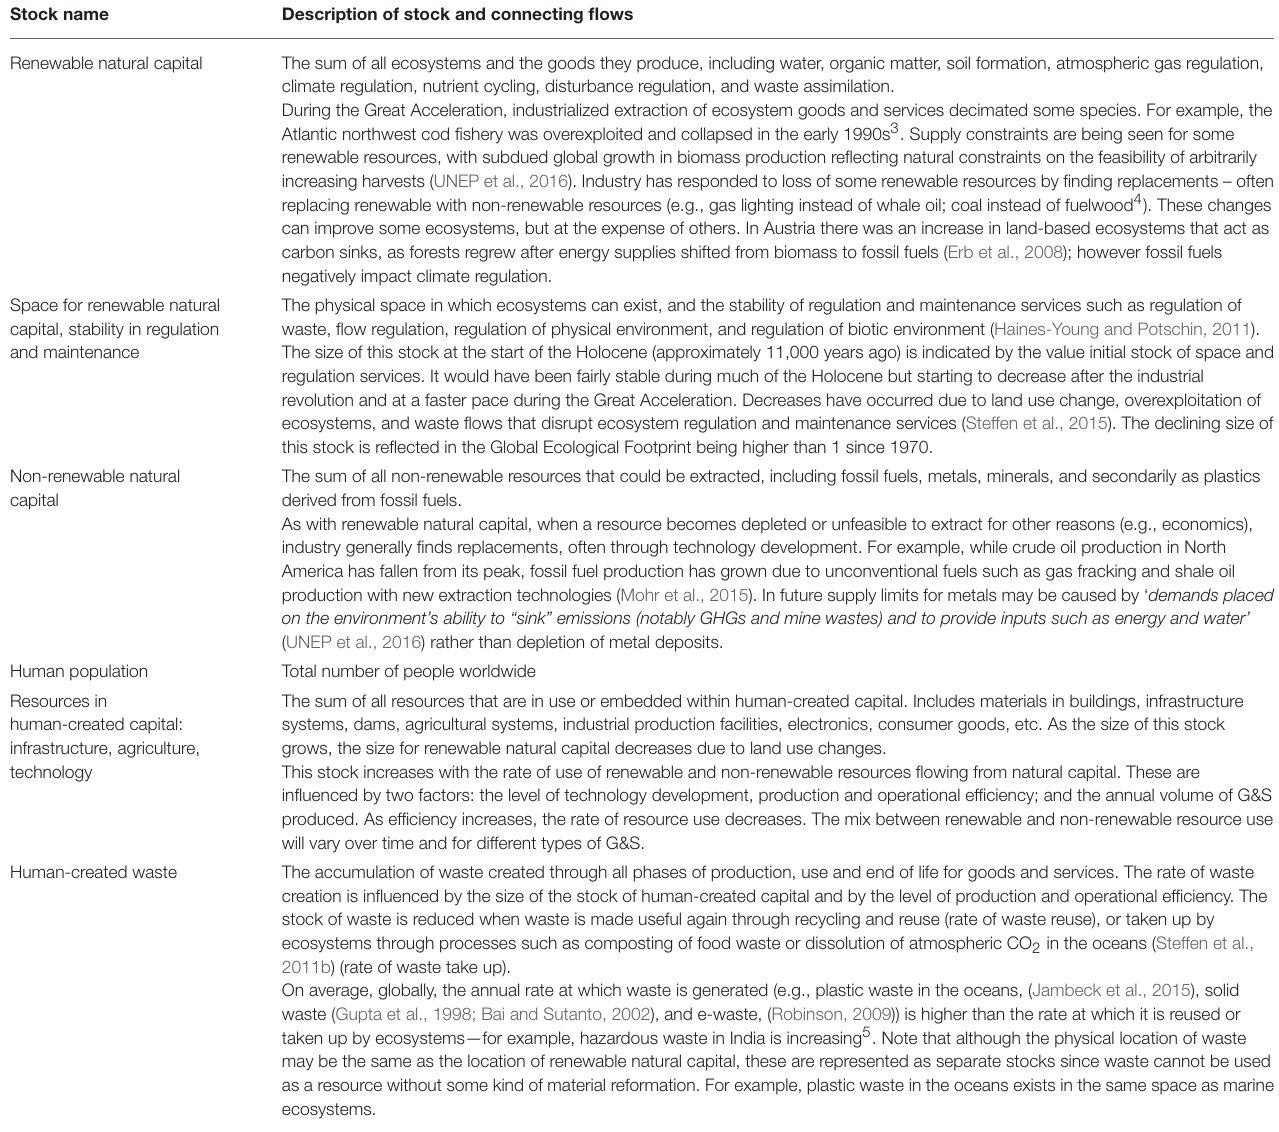
TABLE 2 | Description of model stocks and the flows between